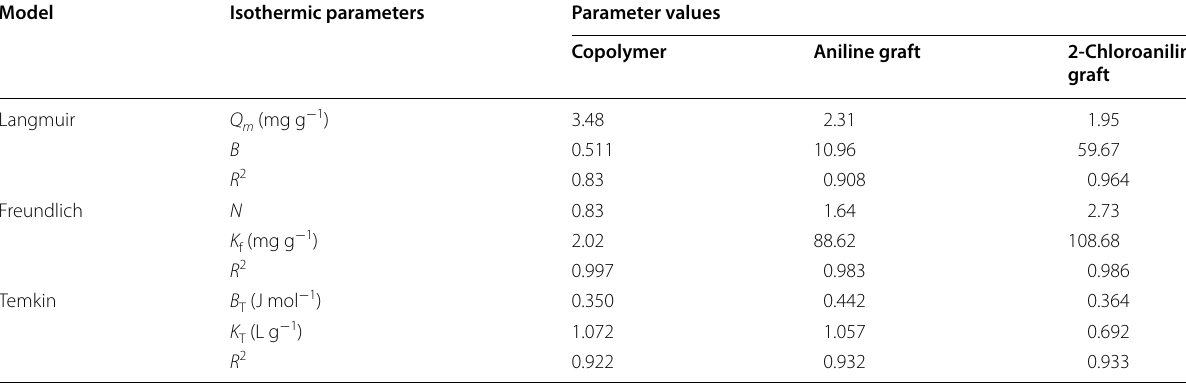
Table 5 Isothermic parameters for the adsorption of Hg 2 + on polymer samples Model Isothermic parameters Parameter values Copolymer Aniline graft 2-Chloroaniline